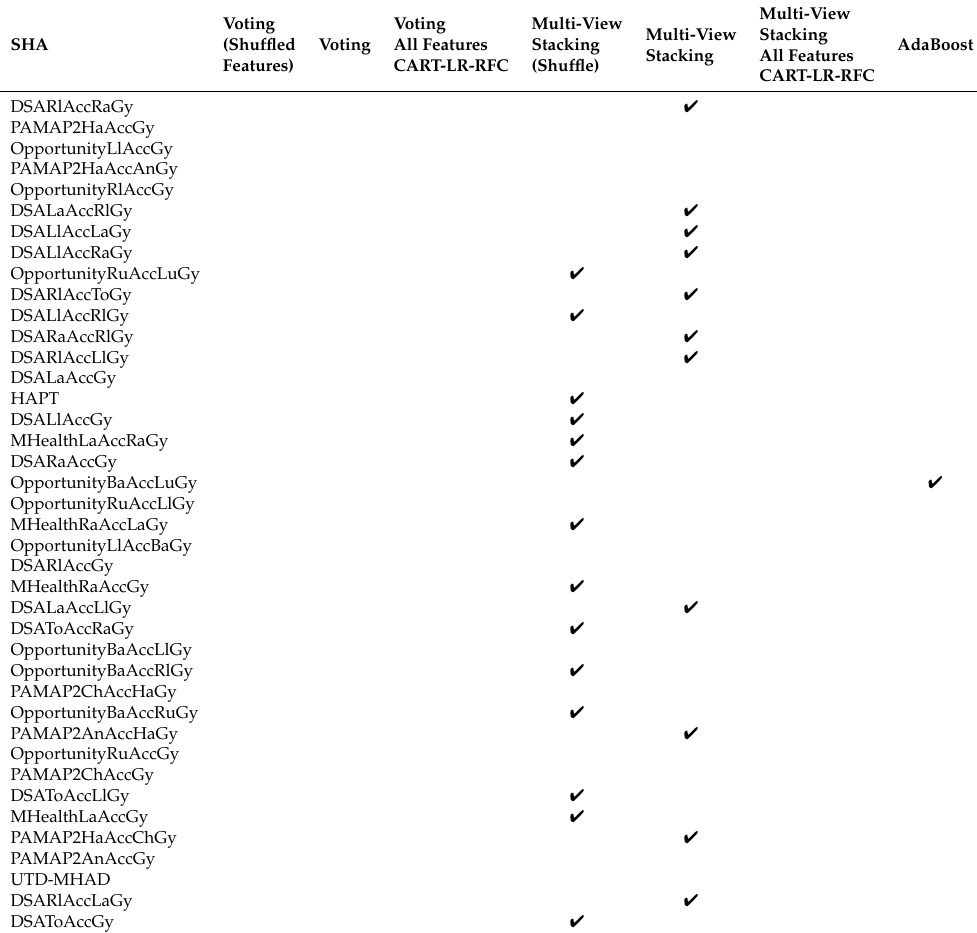
Table 8. Best fusion method for each simple human activities (SHA) data set. A tick ( (cid:52) ) marks the best configuration when it is statistical-significantly better than aggregation; otherwise, it is left blank.